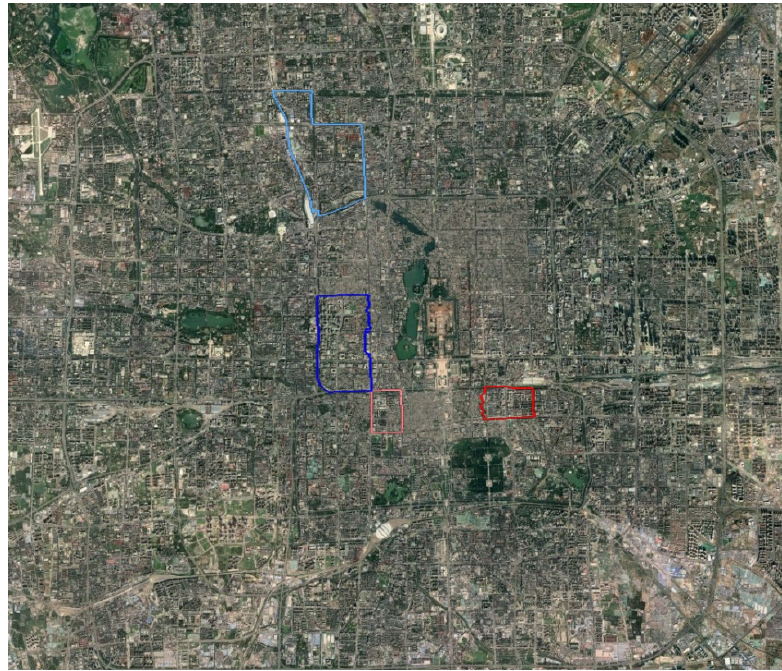
Figure 6. The spatial location of four typical residential areas. Jinrongjie street (high blue light), Chongwenmenwai street (high red light), Chunshu street (low red light) and Beitaipingzhuang street (low blue light).